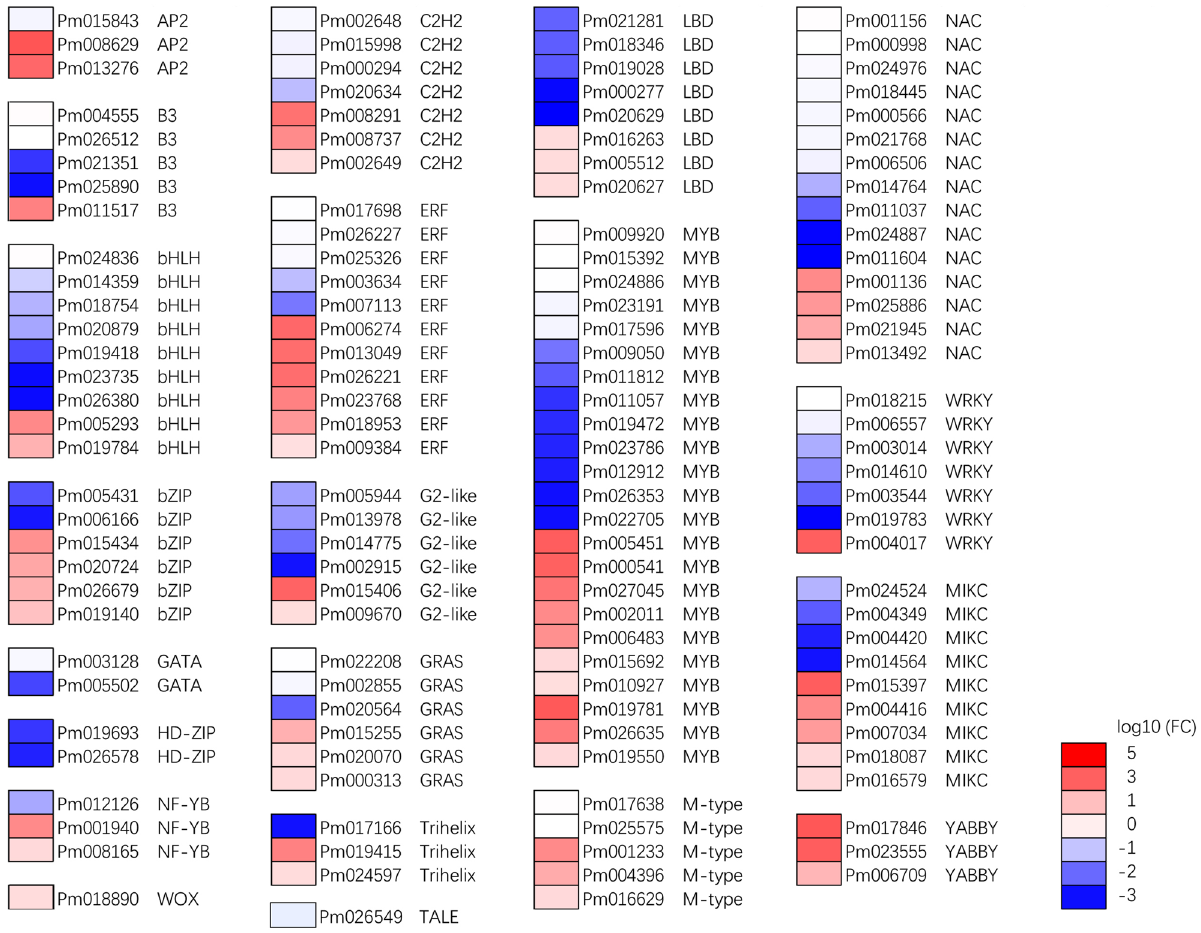
Figure 4. Clustering of differentially expressed transcription factors in upright and weeping stems of P. mume . Red and blue indicate up- and down-regulated genes, respectively, in the three comparisons (log10-fold